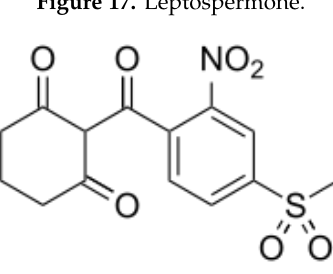
Figure 18. Mesotrione. Figure 18.